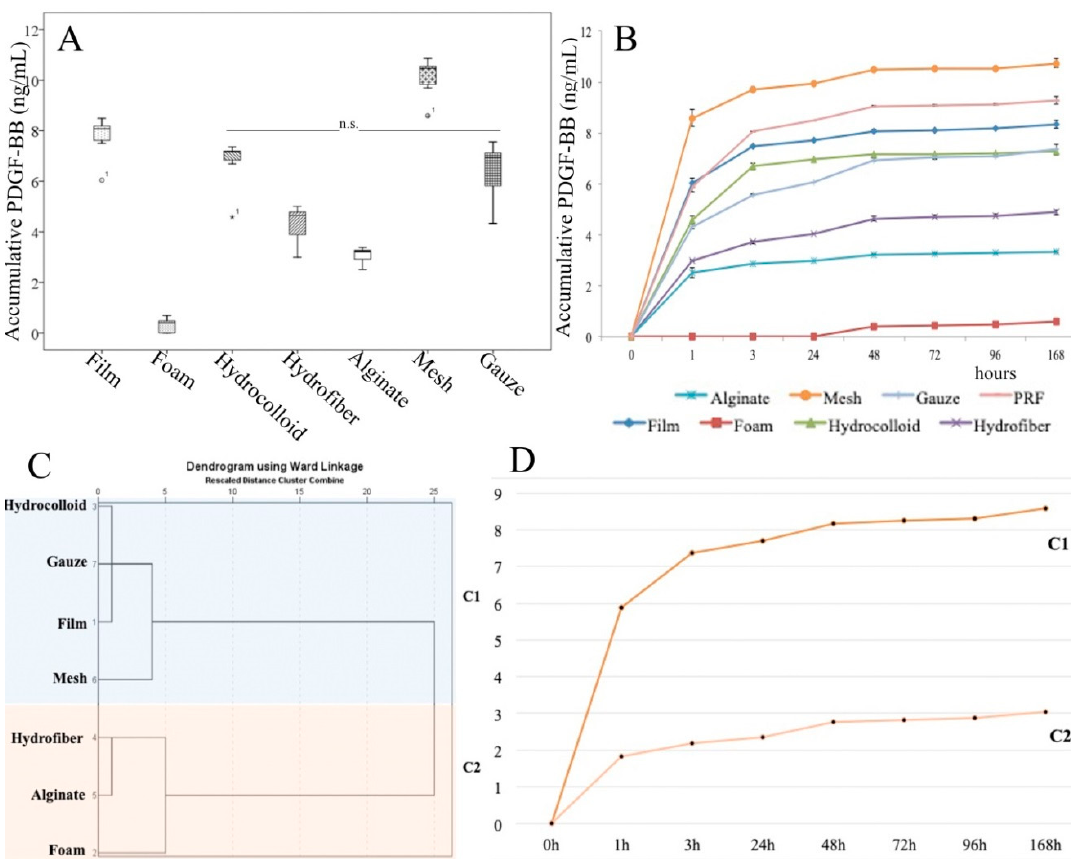
Figure 3. ( A ) Released PDGF-BB differed between dressings, p < 0.001 for all comparisons except “hydrofiber versus alginate”, non-significant differences (n.s.) Box plots depict the median, lower and upper quartile, symbols outside the box represent outliers; ( B ) Pattern of PDGF-BB release over 7 days; ( C ) Dendogram showing the hierarchical relationship between dressings, the X axis is a measure of closeness of either individual dressings or clusters; ( D ) Cluster differences in the PDGF-BB release measured over 7 days.